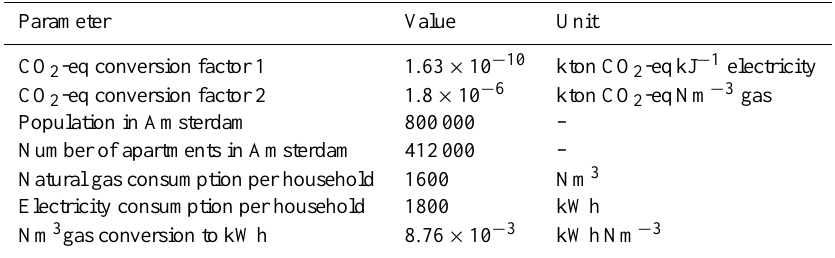
Table 3. Conversion factors and parameters used for CO 2 -equivalents calculation.